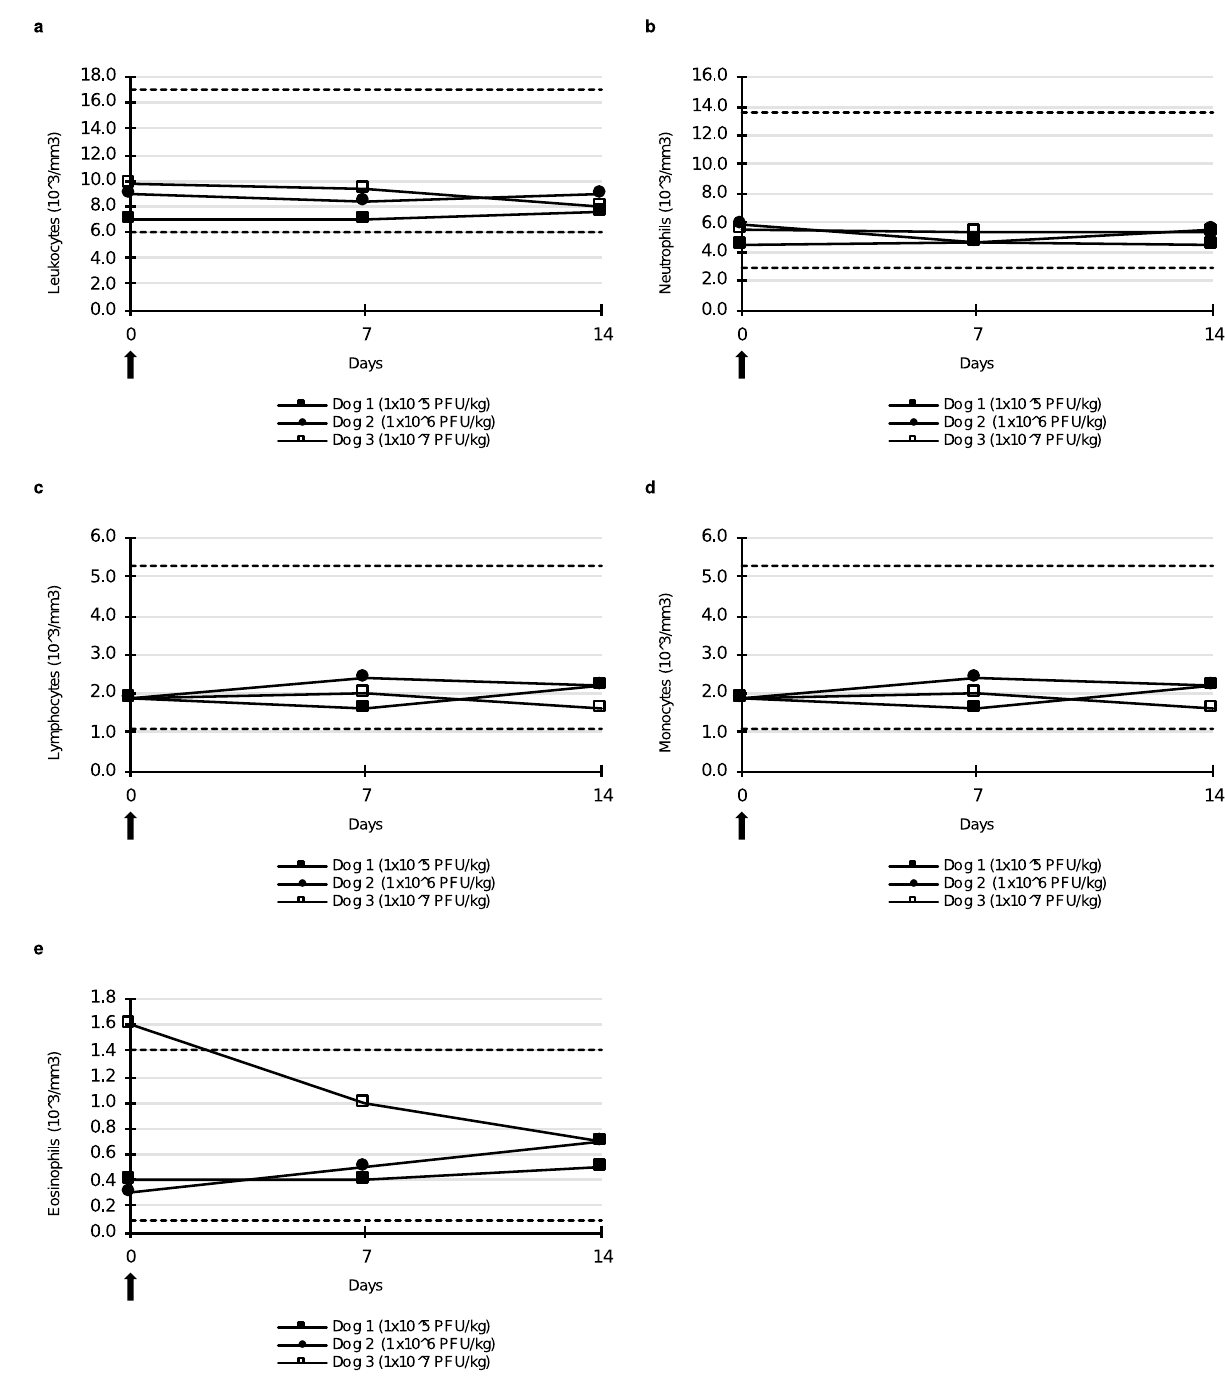
Figure 3. White blood cell count of dogs after a single intravenous injection of TG6002. ( a) Leukocytes. ( b) Neutrophils. ( c) Lymphocytes. ( d) Monocytes. ( e) Eosinophils. ( f) Basophils. TG6002 did not induce significant changes in any blood cell counts after a single injection. Arrows indicate TG6002 administrations. Dotted lines represent reference